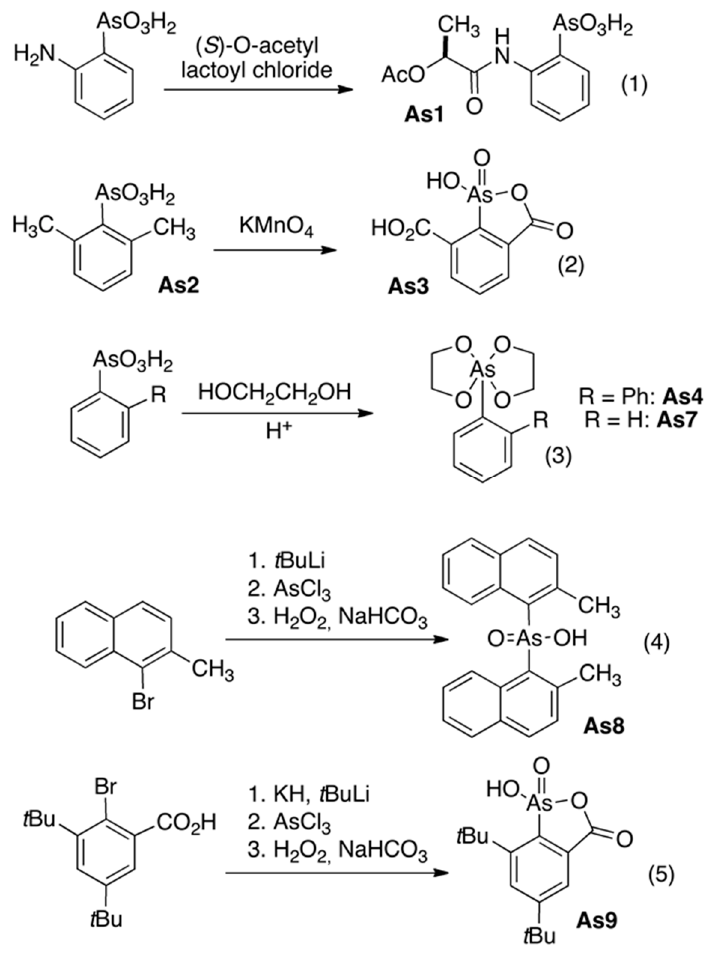
Figure 1. Figure showing the reactions used for the synthesis of organoarsenic Figure 1 . Figure showing the reactions used for the synthesis of organoarsenic compounds.